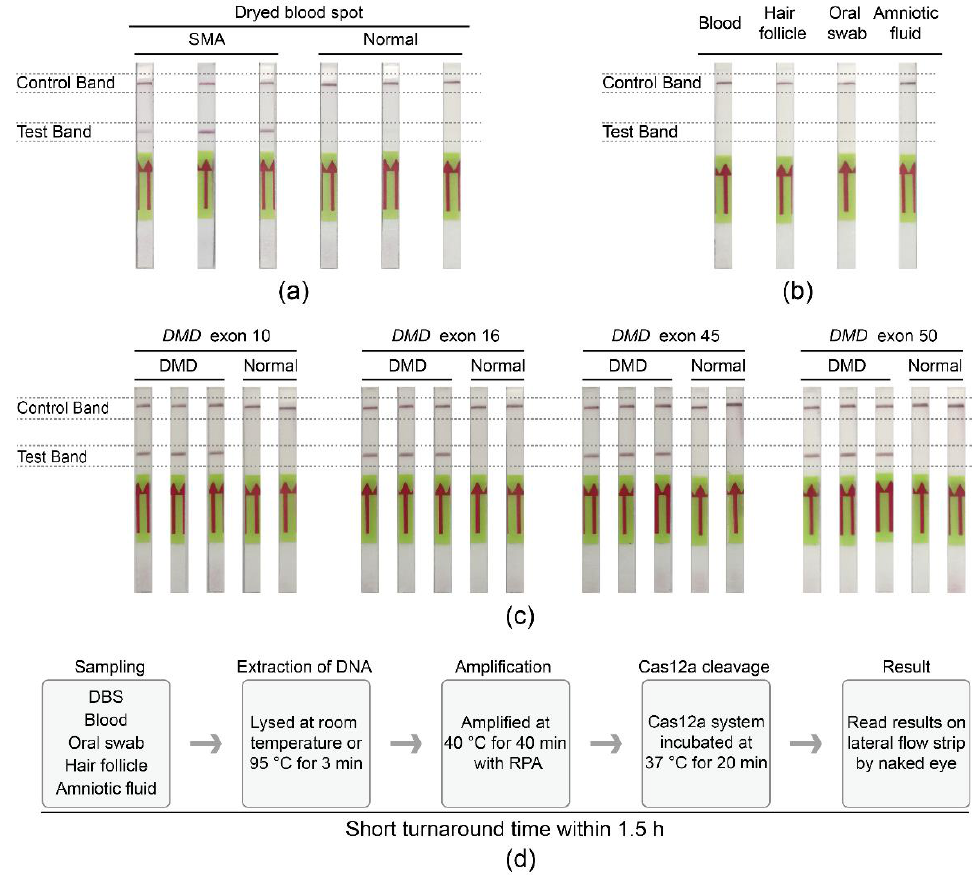
Figure 4. Extensible utility of the Cas12a-strip assay. ( a ) The SMA-Cas12a-strip assay was compatible with DBS samples from newborn screening. ( b ) DNA extracted from blood, hair follicles, oral swabs, and amniotic fluid was also suitable for the SMA-Cas12a-strip assay. ( c ) The Cas12a-strip assay was feasible to detect DMD. ( d ) Process of the SMA-Cas12a-strip assay.